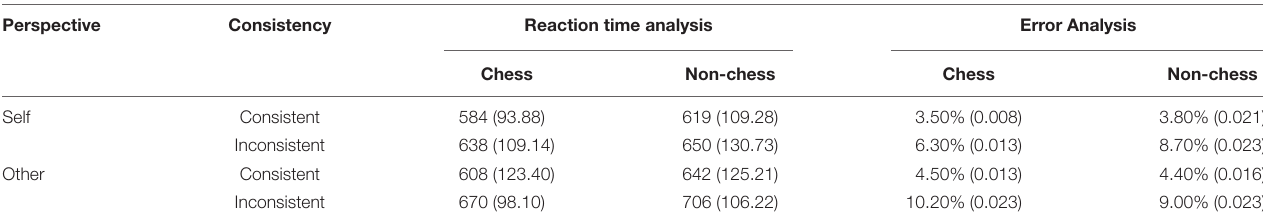
TABLE 3 | Experiment 2 descriptive